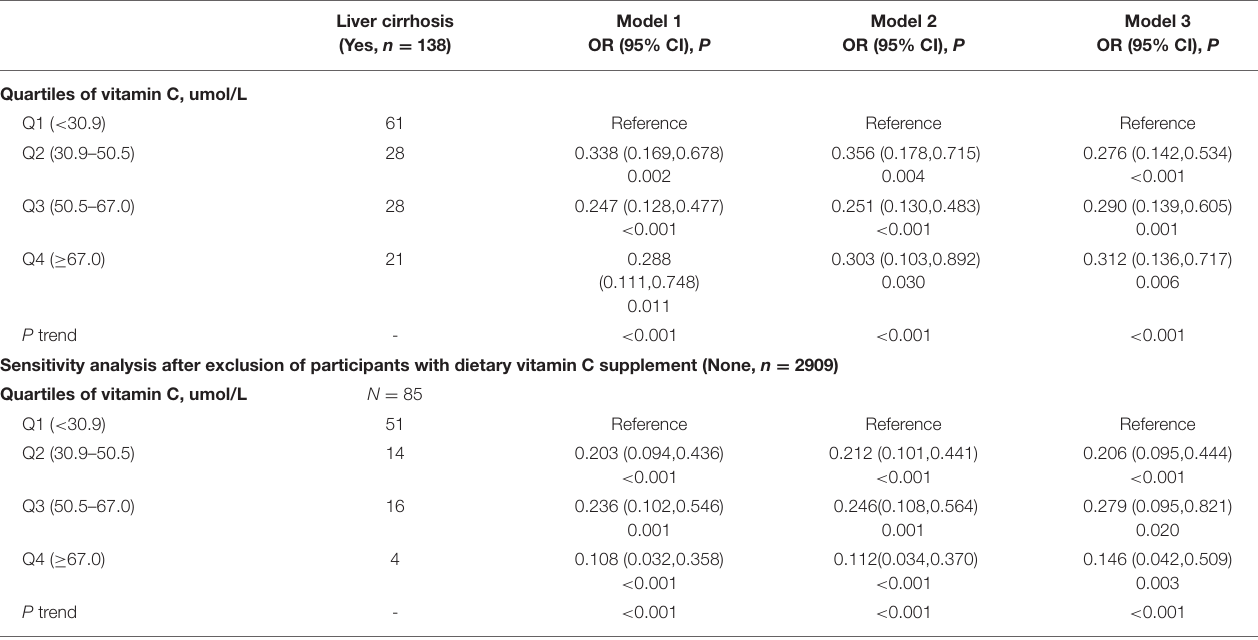
TABLE 5 | Associations between serum vitamin C level and liver cirrhosis, NHANES 2017–2018.